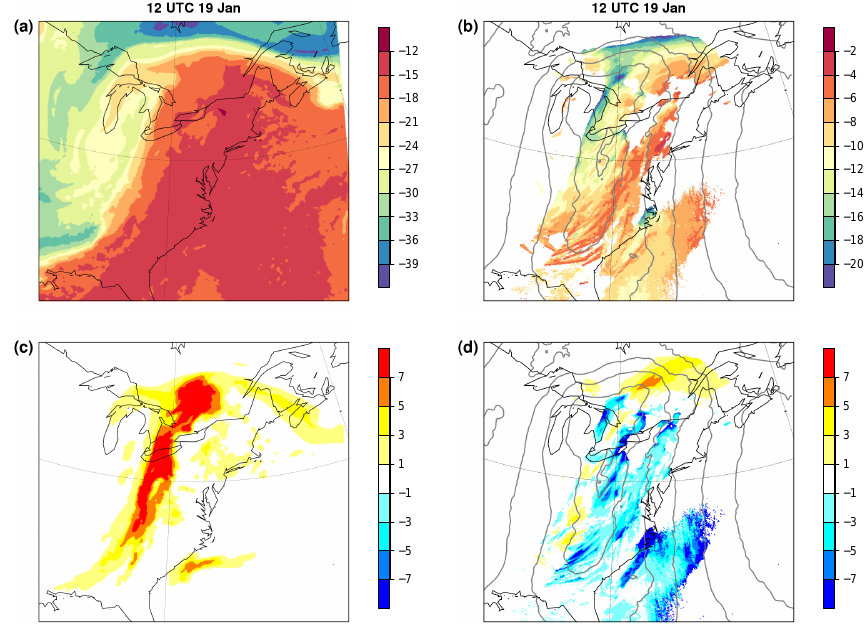
Fig. 12. δ 18 O (in ‰) in (a) water vapour on 850hPa and (b) six-hourly accumulated precipitation at 12:00UTC 19 January from the sensitivity experiment in which isotopic fractionation during the interaction of rain drops and the surrounding water vapour is switched off. Difference plots of δ 18 O (in ‰) in six-hourly precipitation and in water vapour on 850 hPa between sensitivity experiment and reference simulation are shown in (c) and (d) ,